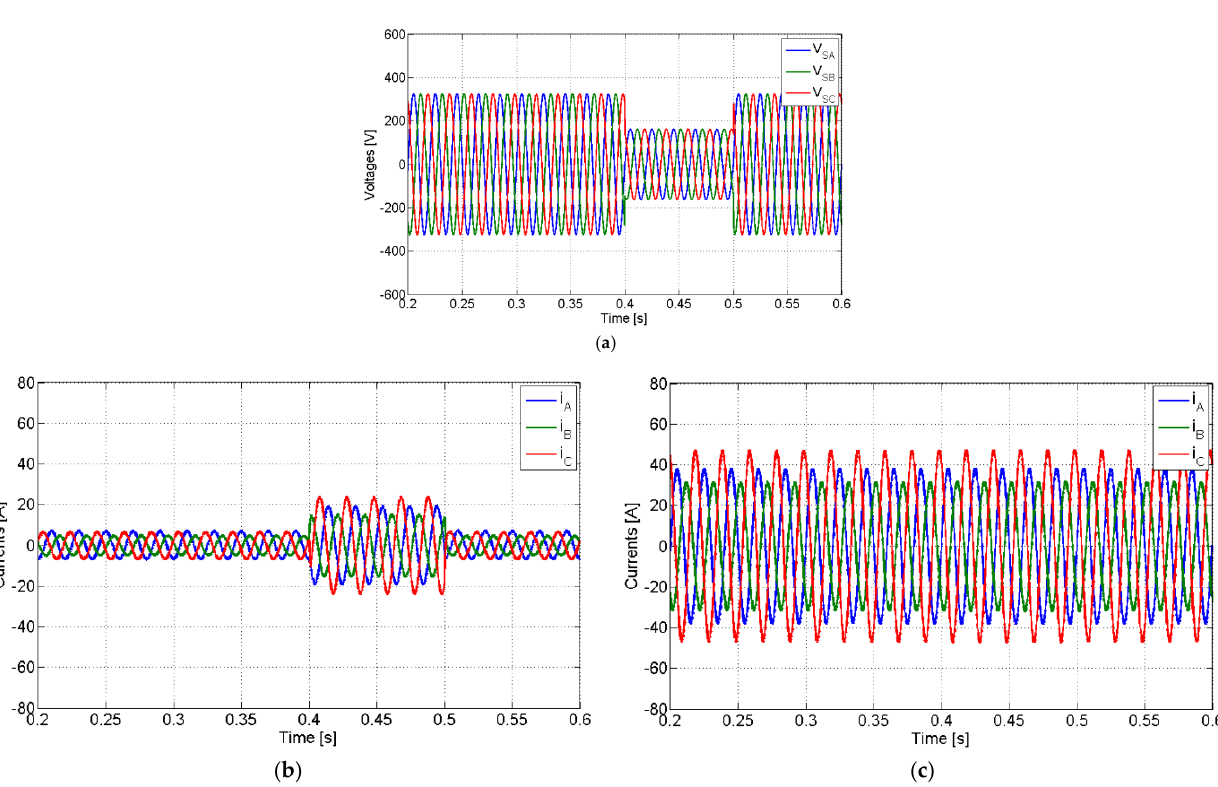
Figure 24. Simulation results for a phase-to-phase fault using a non-linear load and compensation of the active power imbalance ( a ) grid voltages; ( b ) grid currents; ( c ) AC currents of the PV generator.